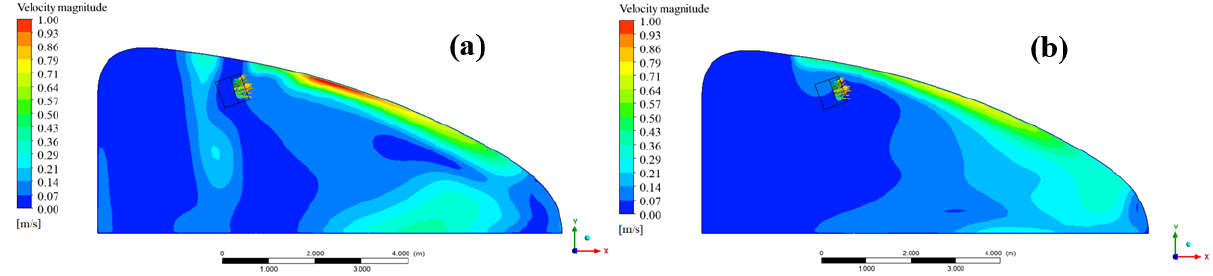
Figure 9. Velocity distribution contours for vertical profiles: plane A ( a ) and plane C ( b ).